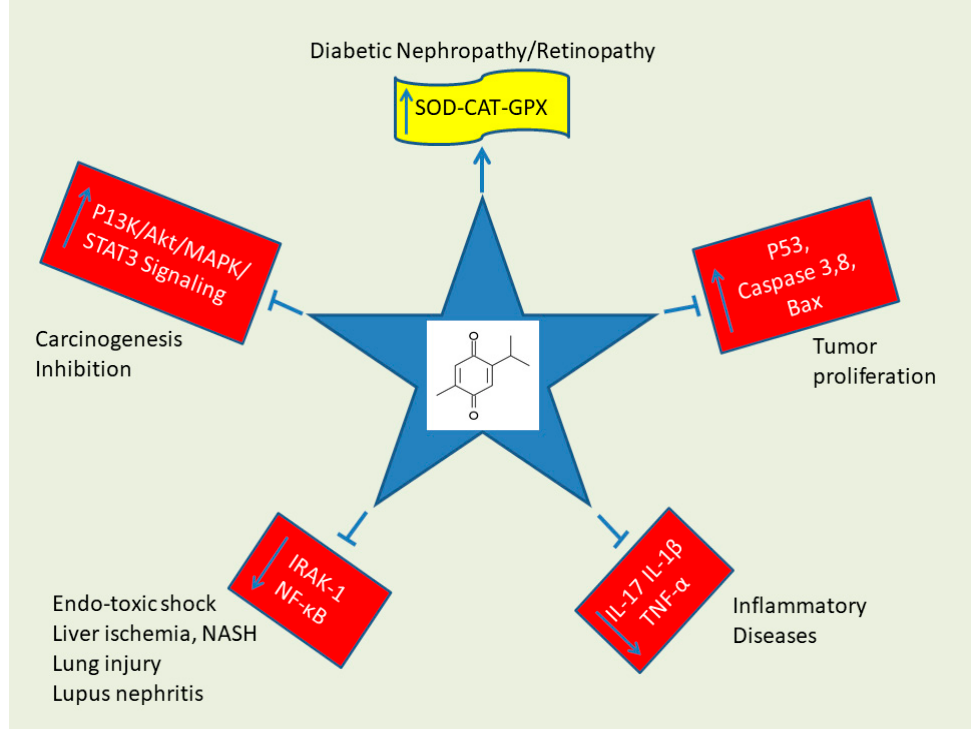
Figure 12. Thymoquinone Effects. See text for details about the various effects of TQ on the physiology and pathology.